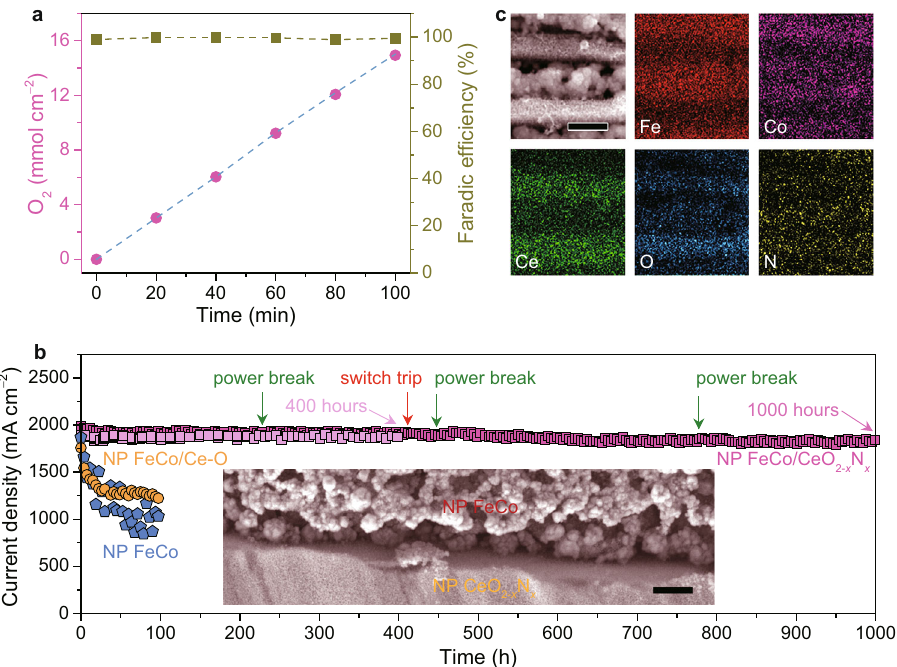
Fig. 4 | OER performance of nanoporous FeCo/CeO 2 − x N x electrode. a Comparison of oxygen volume (pink dots) and faradic ef fi ciency (dark yellow squares) for nanoporous (NP) FeCo/CeO 2 − x N x electrode and its theoretical value (dashedline)calculatedbasedontheamountofconsumedchargesoverthecourse of electrolysis. b Stability test (current density versus time) of NP FeCo/CeO 2 − x N x electrode (pink squares) at 1.54V versus RHE for 400 and 1000h, respectively. During the 1000-hour stability test, there take place power break and switch trip